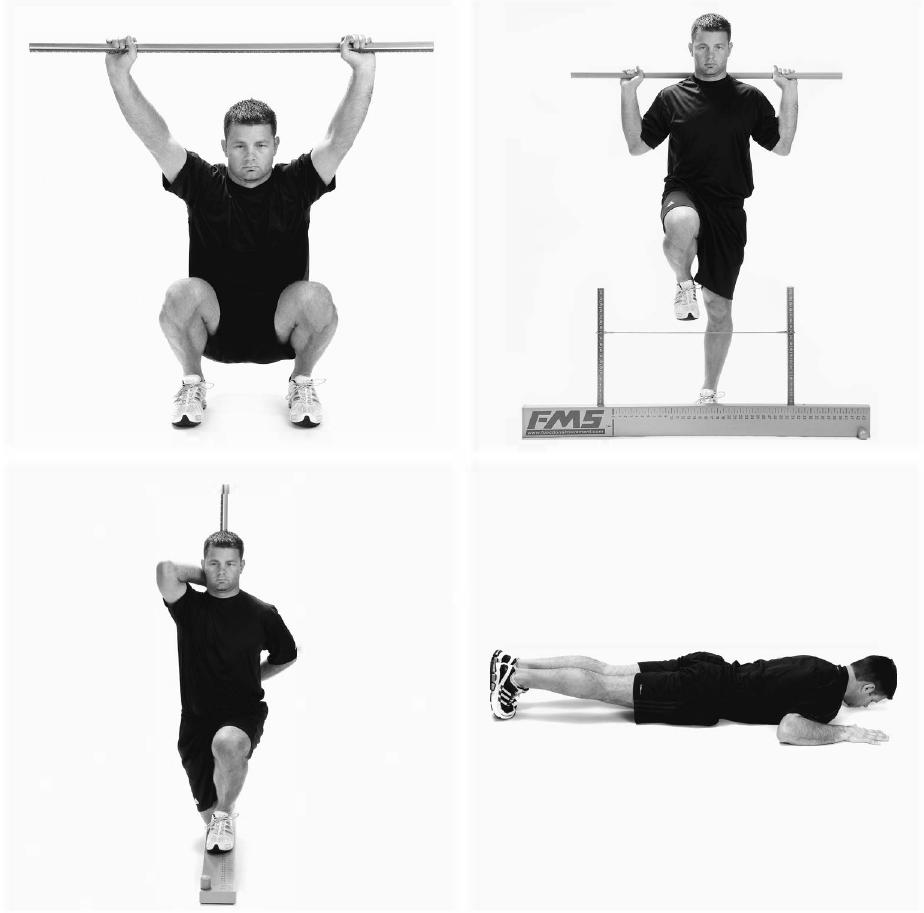
Figure 1. FMS exercises included in the recorded dataset. From left to right, from top to bottom: Deep Squat (DS), Hurdle Step (HS), Inline Lunge (IL) and Trunk Stability Pushup (TSP)